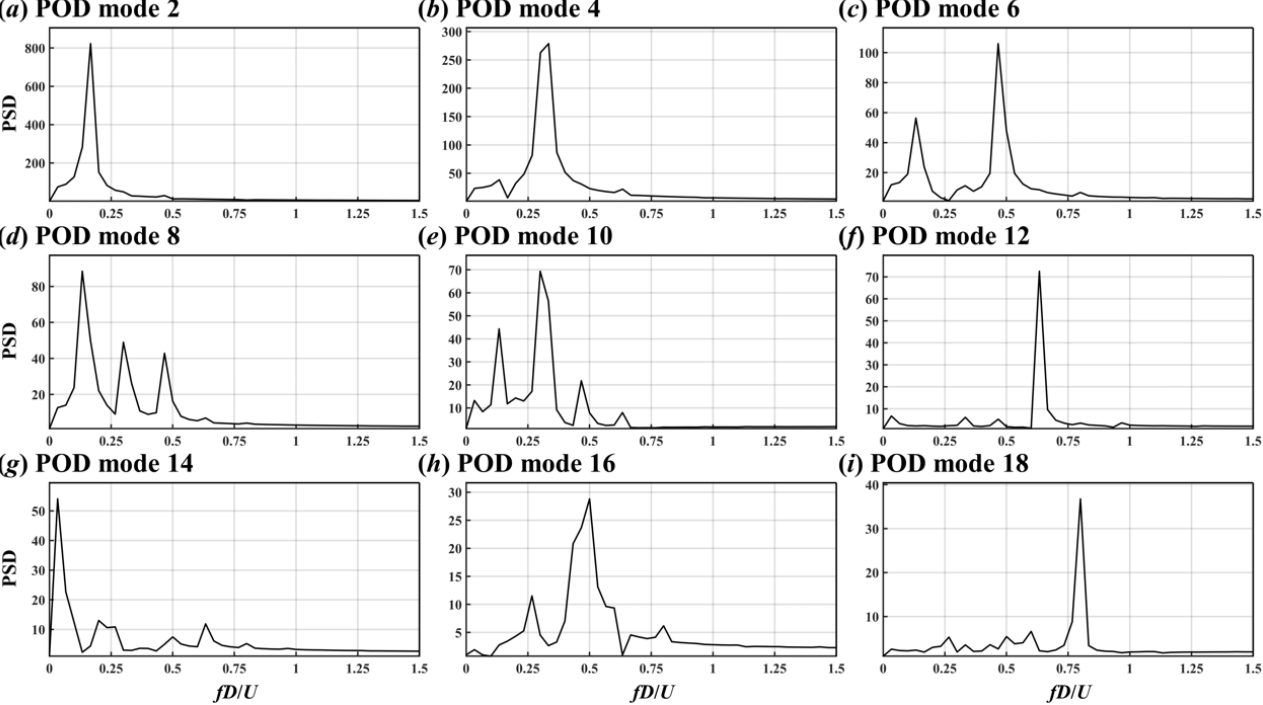
Figure 30. PSDs of the 2nd ( a ), 4th ( b ), 6th ( c ), 8th ( d ), 10th ( e ), 12th ( f ), 14th ( g ), 16th ( h ), and 18th ( i ) POD modes for the flow around the two crossing cylinders in 90° arrangement.